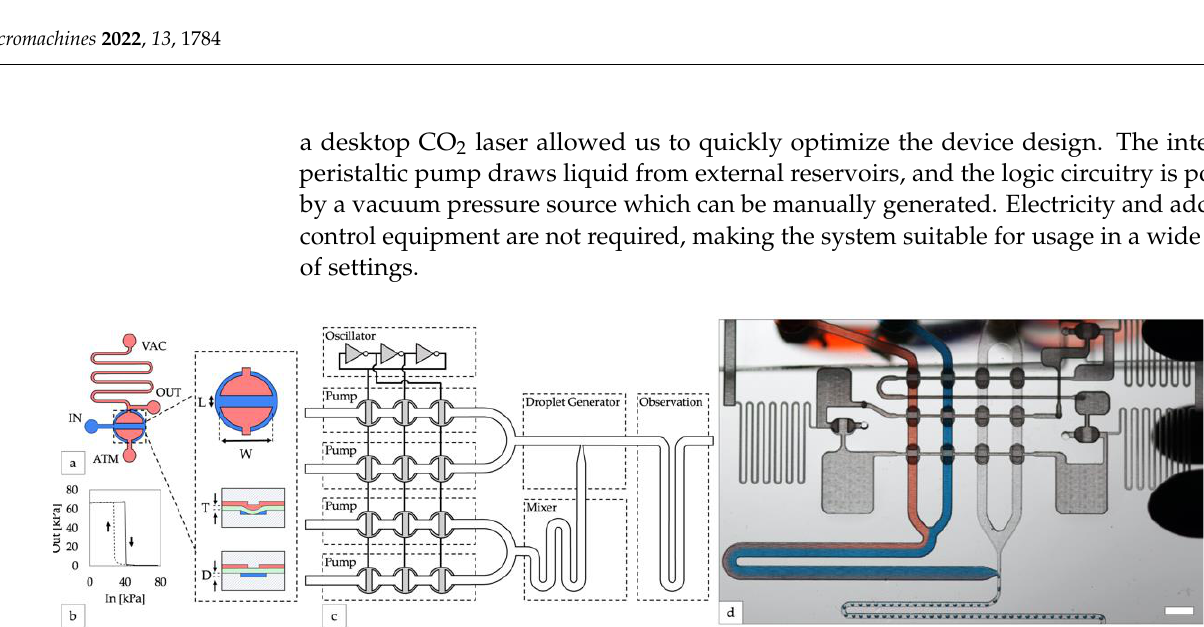
Figure 1. Design of integrated controller for droplet generator. ( a ) An inverter gate is created by attaching high and low resistance channels to opposite sides of a valve. Channels on the top and bottom layers are shown in red and blue, respectively. A top-down valve detail shows dimensions of the valves used in this study (length L = 0.5 mm, width W = 1 mm). Cross-section valve detail shows an open valve (upper) and closed valve (lower) with elastomeric membrane in green (thickness T = 250 µm) and depth of the displacement chamber (depth D = 150 µm). ( b ) The transfer function of a laser-cut inverter gate produces a sharp non-linear switch in output vacuum as input vacuum is increased (solid line, valve opening) and decreased (dashed line, valve closing). ( c ) Block diagram of the droplet system. A ring oscillator created from inverter gates synchronizes four peristaltic pumps. ( d ) Photo of the device generating water-in-oil droplets containing blue and red dye (scale bar = 3 mm).